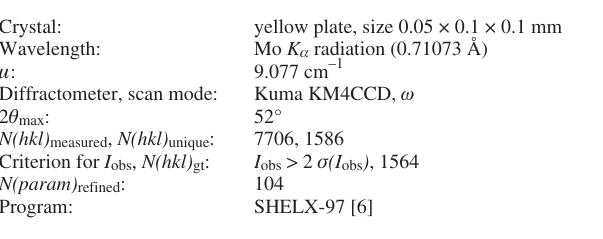
Table 1. Data collection and handling.